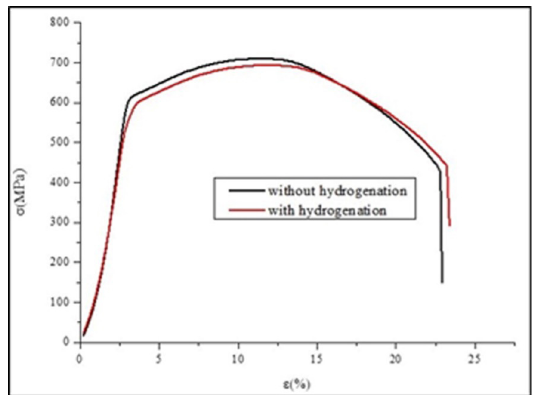
Figure 12. Results of tensile test of ASTM A182 F22 steel extracted from the welded joint without and with hydrogenation.